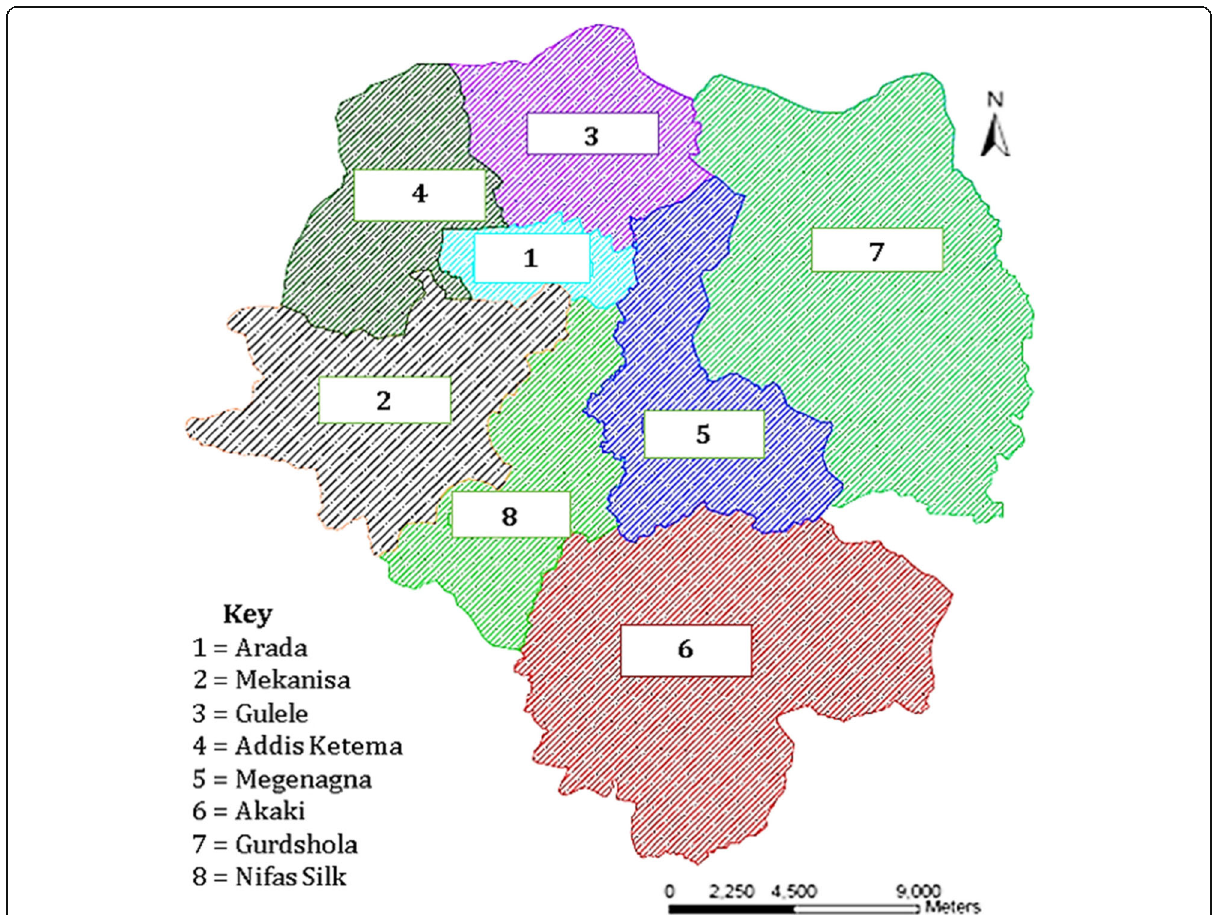
Fig. 2 AAWSA water distribution branch offices in the city, which do not follow the sub-city